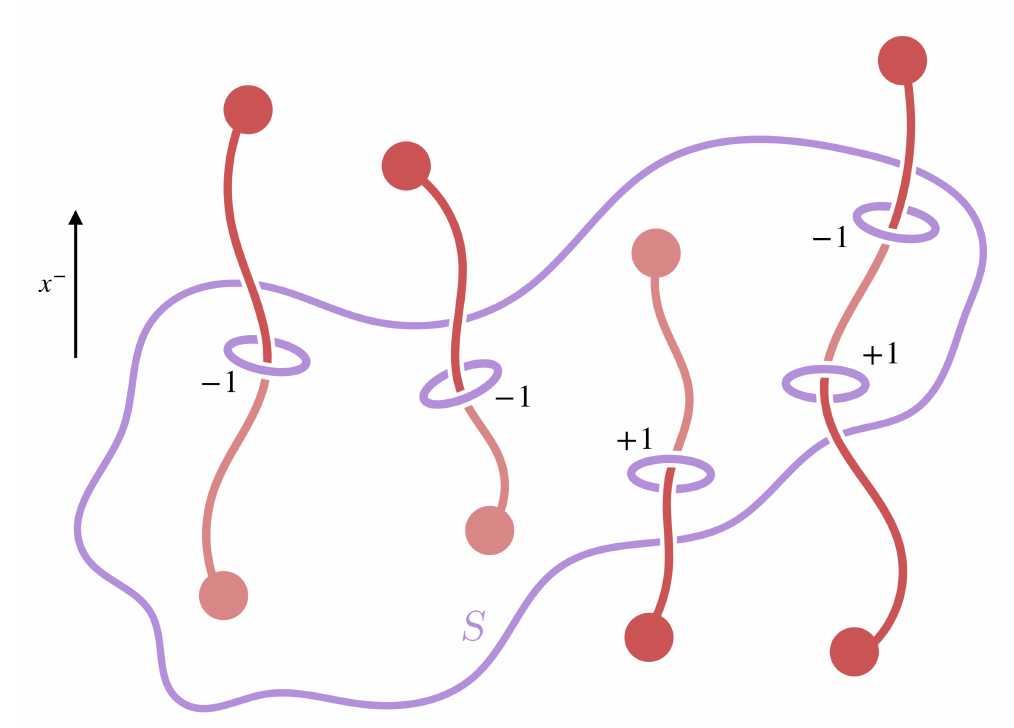
Figure 3 . The instanton charge Q ( S ) = − 1 for a closed 4-dimensional surface S , which intersects some disjoint worldlines. Let M be the region in R 5 enclosed by S . Then, the two leftmost worldlines are those of anti-instantons created in M , and annihilated outside. The third describes an anti-instanton created outside M , and annihilated inside. The final, rightmost anti-instanton is both created and annihilated outside M , but has worldline that nonetheless passes through M